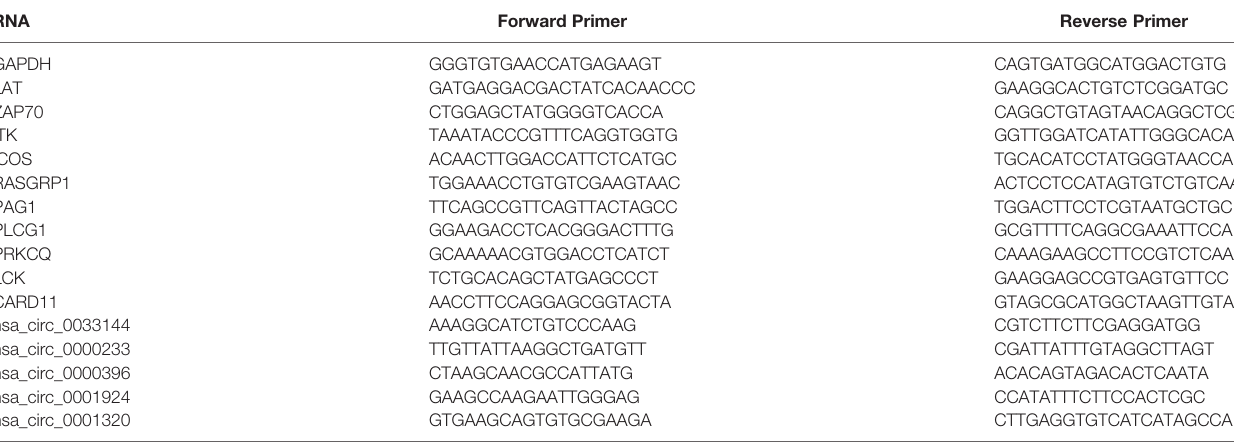
TABLE 1 | Primers used for quantitative real time